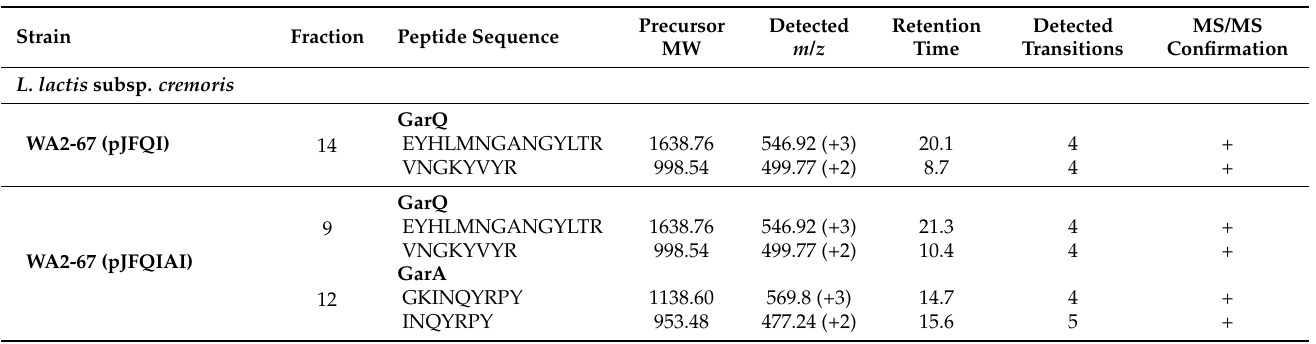
Table 6. Peptide fragments identified by MRM-LC-ESI-MS/MS (QTRAP) in eluted purified fractions from supernatants of L. lactis subsp. cremoris WA2-67 (pJFQI) and L. lactis subsp. cremoris WA2-67